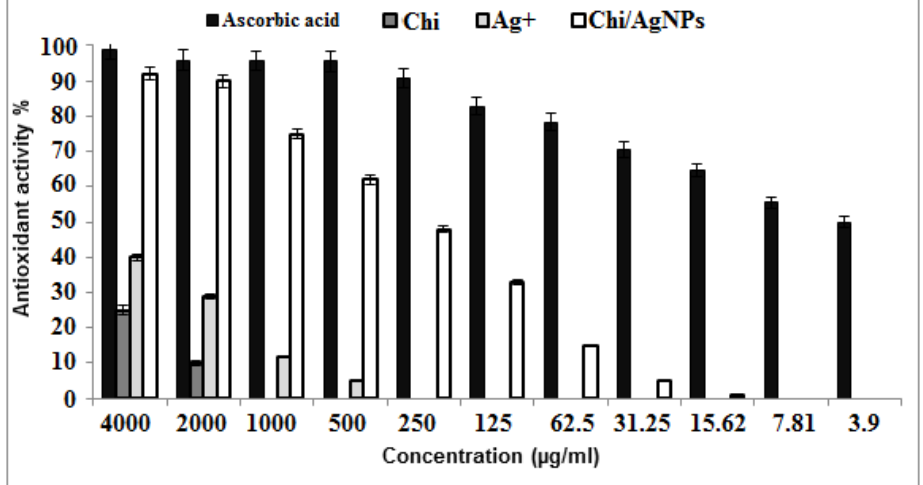
Figure 7. Antioxidant activity of Chi, Ag+, and Chi/Ag-NPs.